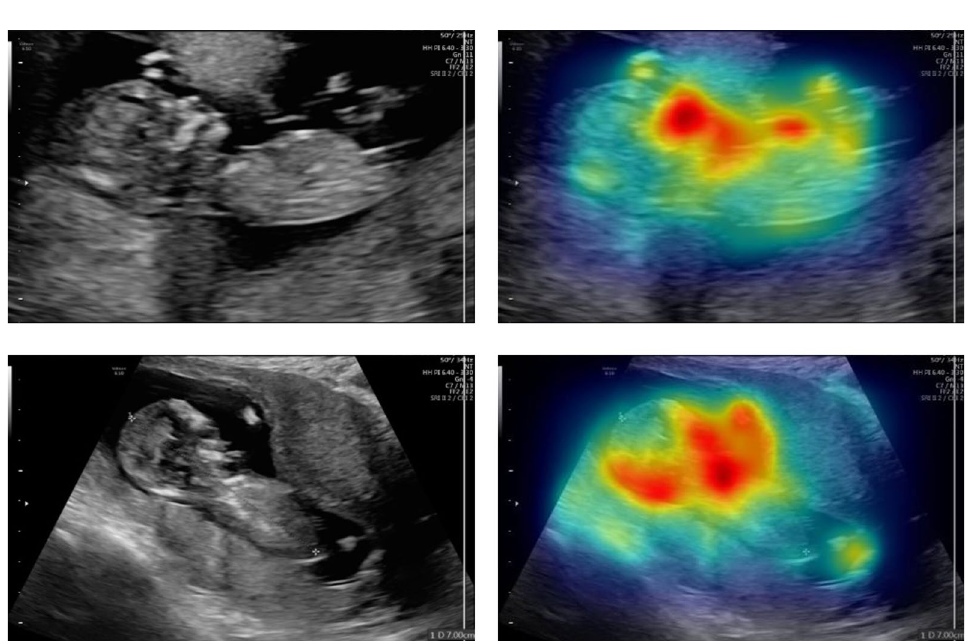
Figure 9. Samples of the salient output results of Net1 for the corresponding image using CRL